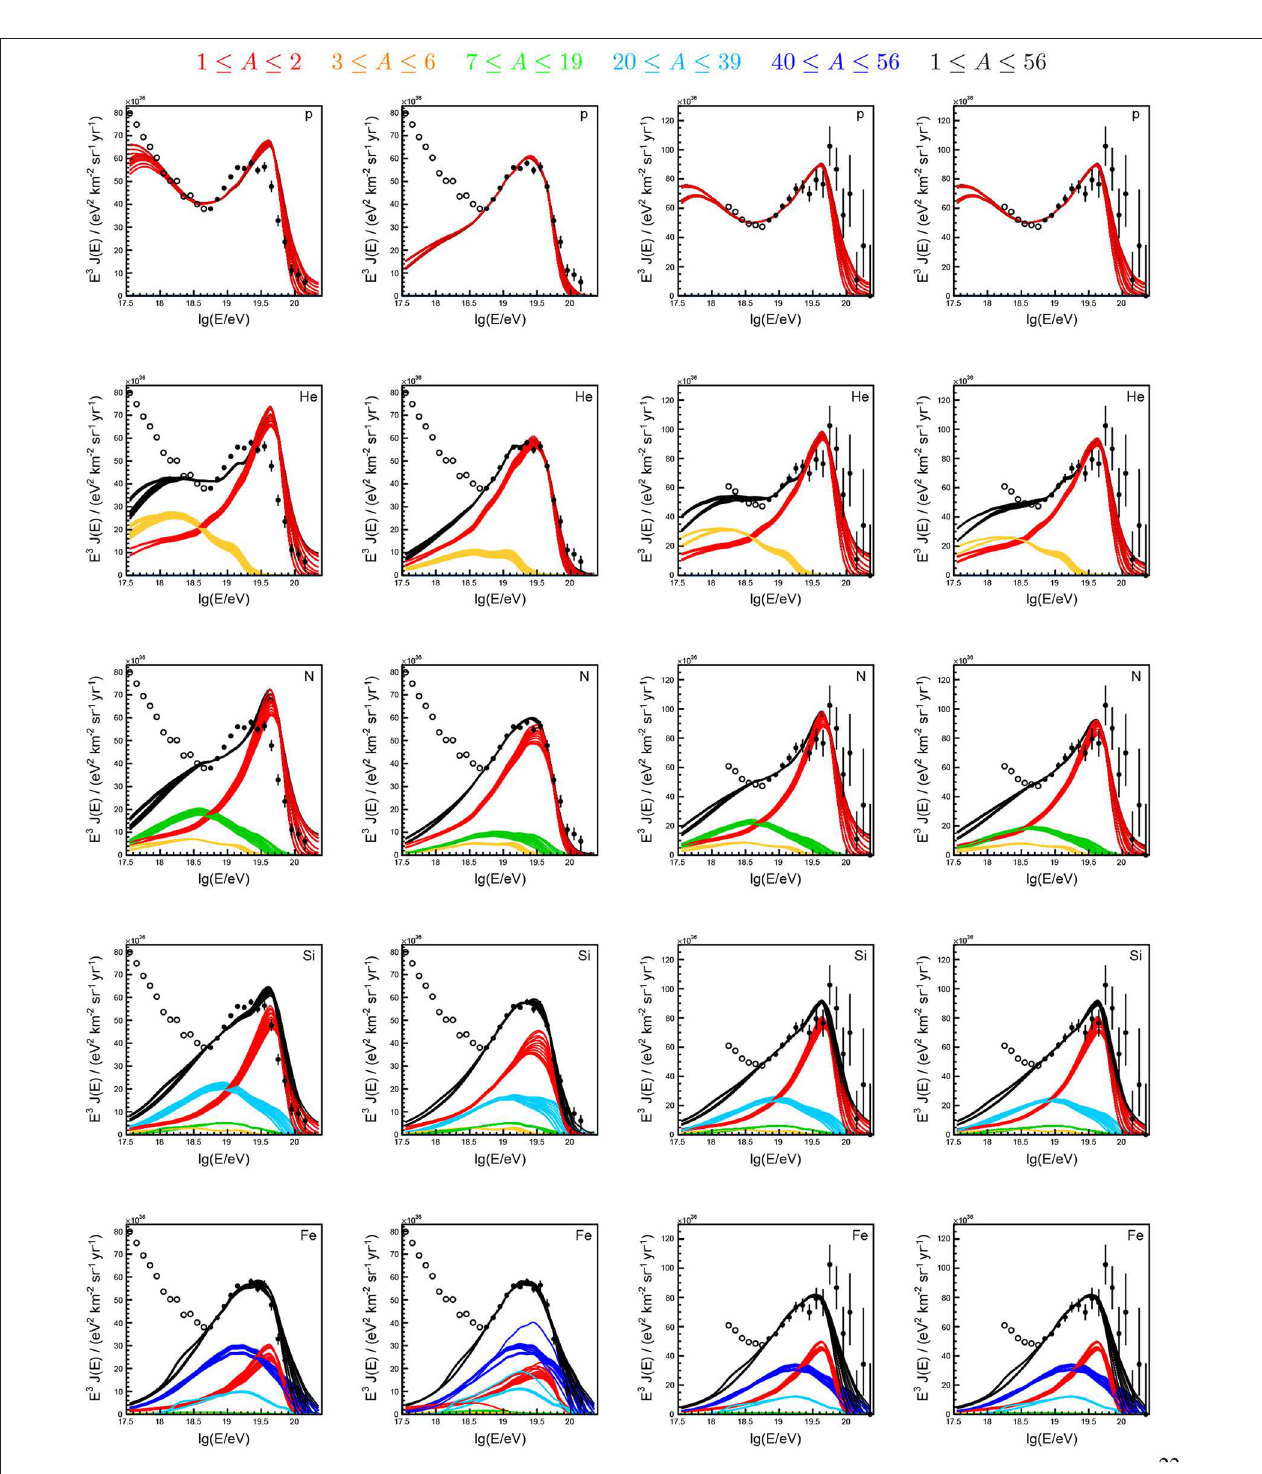
FIGURE 13 | Illustration of pure GZK scenarios (free injection index, maximum energy fixed at 10 22 eV, first and third column) and scenarios with a freely floating maximum energy (free injection index and maximum energy, second and fourth column) for different primary masses. The first and second columns are for the Auger measurements of the flux (Abraham et al., 2008) and the third and fourth column for TA (Abbasi et al., 2018e). Open symbols were not used in the fit. Different model lines are for different distances of the closest source (1 Mpc to 100 Mpc) and for two source evolutions (SFR Robertson et al., 2015 and AGN Ahlers et al., 2005). The simulations were performed with CRPropa3 (Alves Batista et al., 2016) using the EBL model from Gilmore et al. (2012). M. Unger for this review.